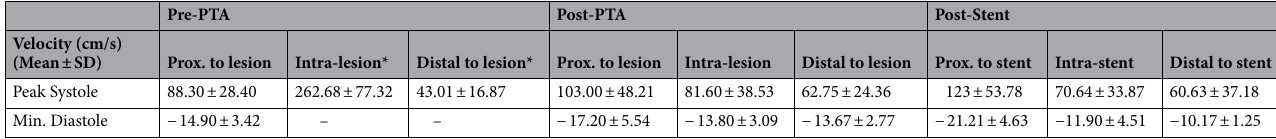
Table 3. The average velocities of 24 patients measured by DUS prior to and following endovascular treatment. *Represents monophasic flow.